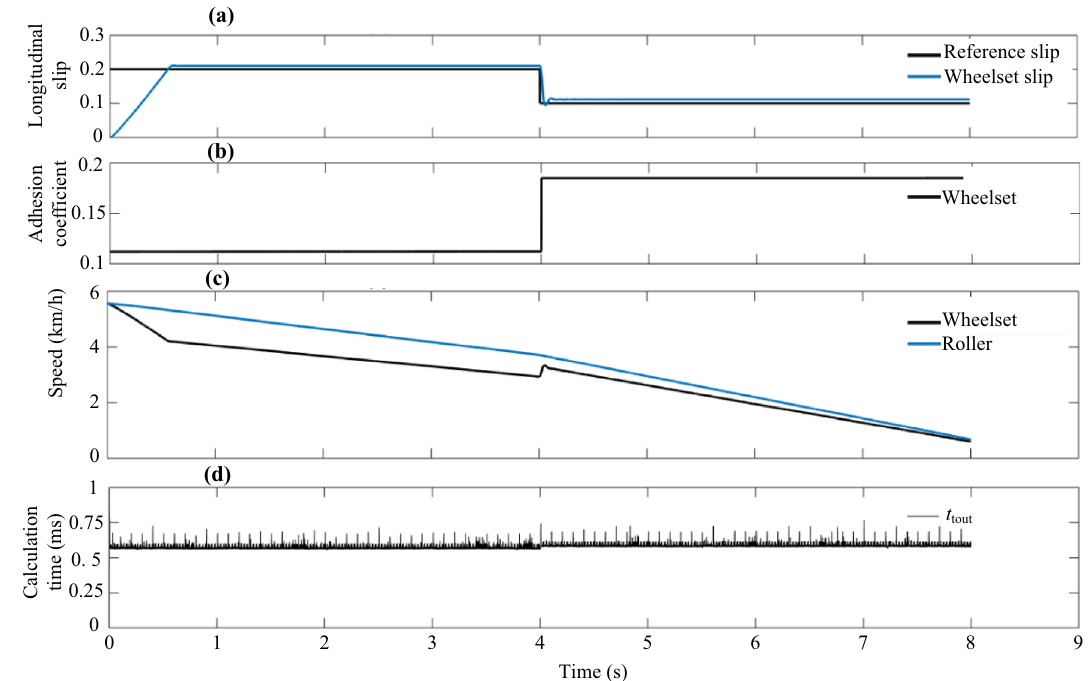
Fig. 18 Parameters in time domain: a reference slip and an estimated longitudinal slip of wheelset, b adhesion coefficient, c speed of the wheelset versus roller, and d total time for each output step of 1